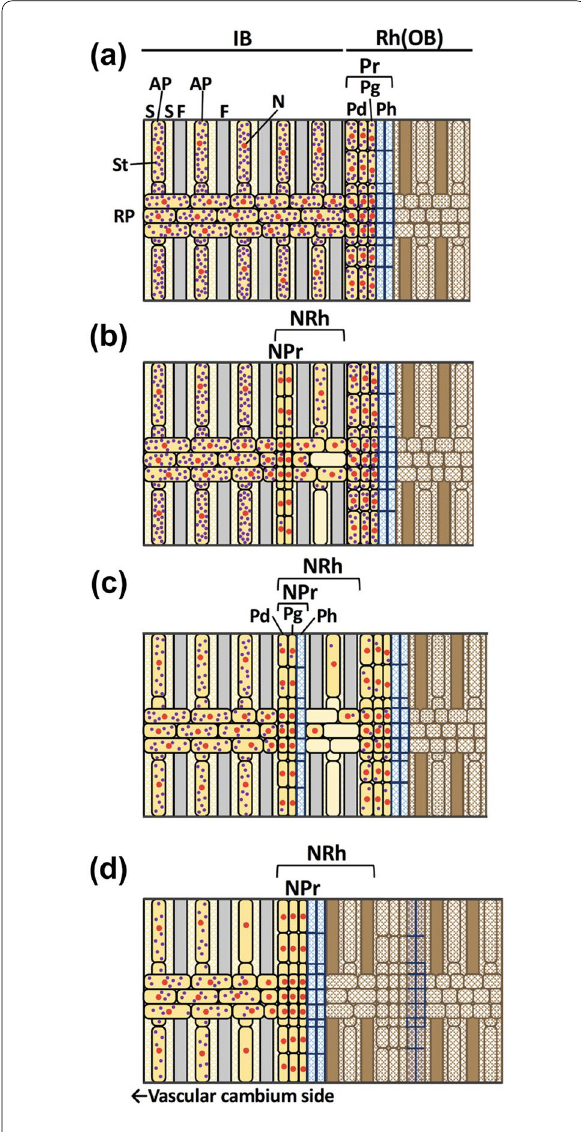
Fig. 7 Schematic diagrams showing the process of rhytidome formation in Cryptomeria japonica (in radial view). a Stage 0: all axial and ray parenchyma cells in the inner bark and innermost phelloderm contain nuclei and large amounts of starch grains. b Stage 1: a new periderm is formed from axial and ray parenchyma of the outer part of the inner bark. In the secondary phloem between the new periderm and previous periderm, sporadic disappearance of nuclei and decrease in the amounts of starch grains are observed in axial and ray parenchyma cells. c Stage 2: new phelloderm and phellem are producing, indicating the development of a new periderm. In the outer region of the new periderm, many axial parenchyma cells have no nuclei. The amount of starch grains decreases across the entire inner bark and new rhytidome, particularly in the parenchyma cells outside the new periderm. d Stage 3: the secondary phloem outside the new periderm become indistinguishable from the rhytidome with brown cell walls, no nuclei and no starch grains. AP axial parenchyma cell, F phloem fiber, IB inner bark, N nucleus, NPr new periderm, NRh new rhytidome, Pr periderm,